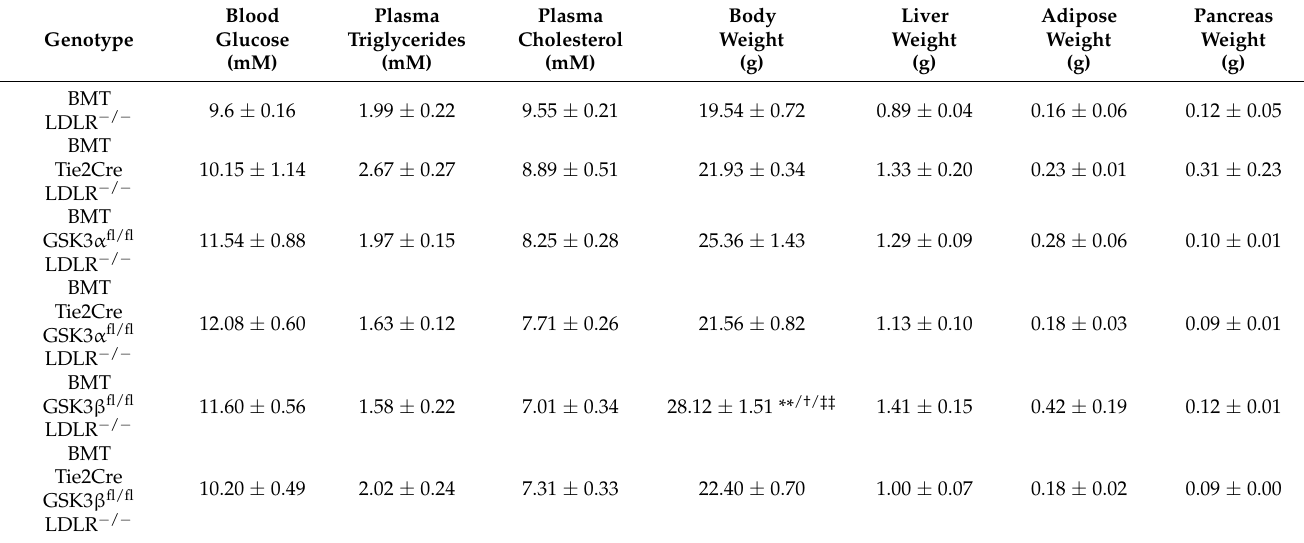
Table 2. Metabolic Parameters for BMT endothelial knockout